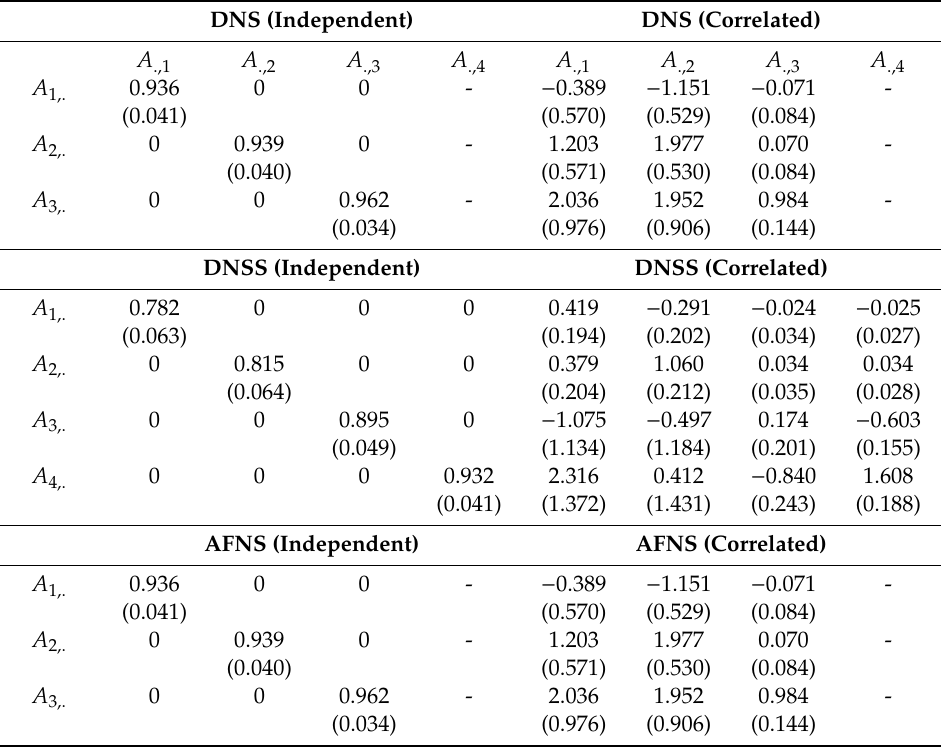
Table 2. The transition matrix A of the DNS, DNSS, and arbitrage-free Nelson–Siegel (AFNS)